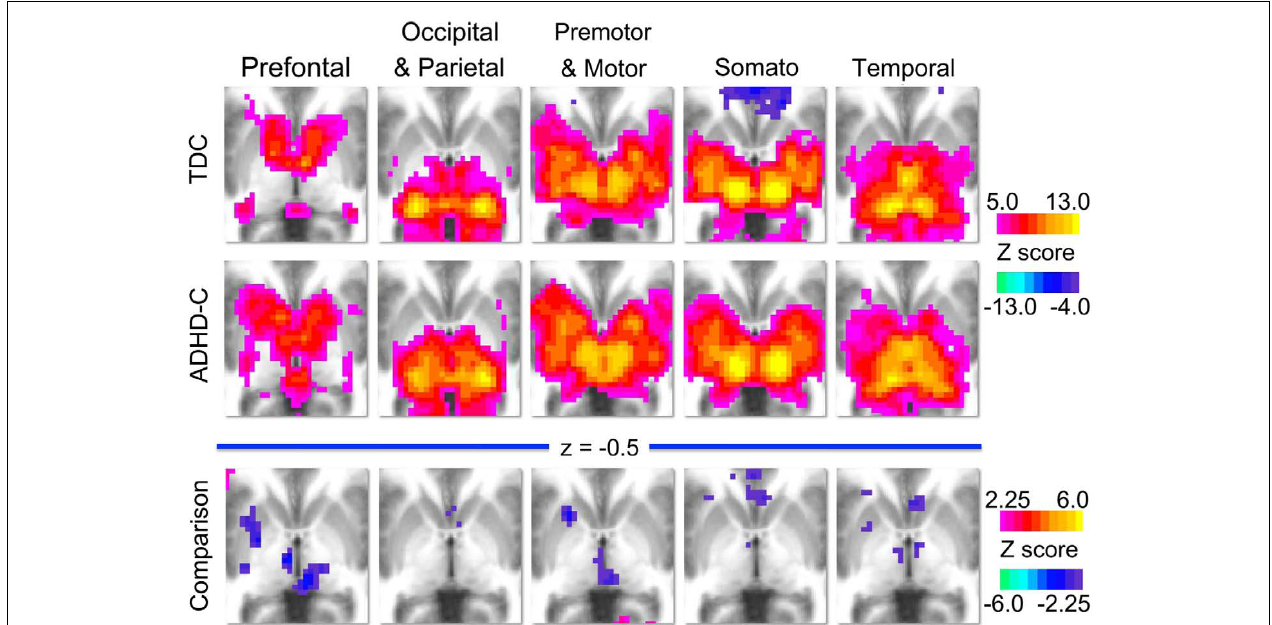
70 children with ADHD-combined subtype (ADHD-C).The third row illustrates the voxelwise maps for the comparison analysis, where warm colors (positive z -scores) indicate areas where connection strength is greater inTDC, and cool colors (negative z -scores) indicate areas where connection strength is greater in the ADHD-C